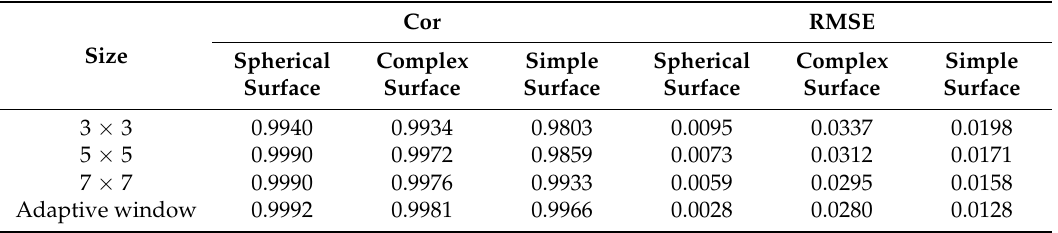
Table 4. Evaluation result of the recovery effect of the three models reconstructed using different evaluation windows of F